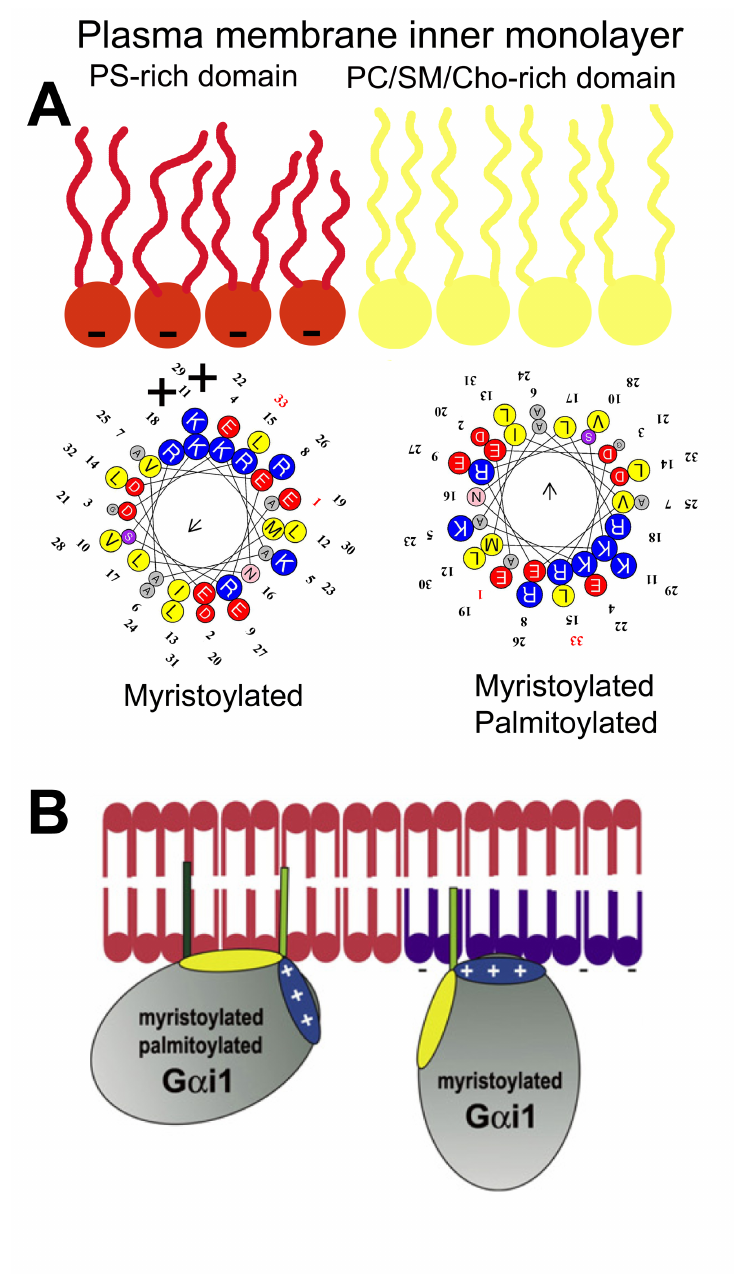
Figure 1. G α i 1 protein–membrane interactions. ( A ) Geometry of the N-terminal α -helix with a myristoyl moiety interacting with PS-rich (negatively charged, red) membrane microdomains (left helix), and the α -helix with myristoyl and palmitoyl moieties (right helix) that interact with PC and / or SM and / or Chol microdomains (yellow). ( B ) Scheme of acylated G α i 1 protein–membrane interactions (Adapted from